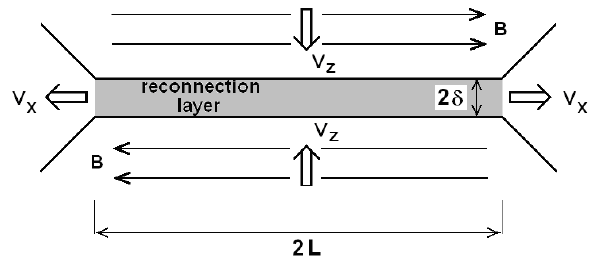
Fig. 1. The Sweet–Parker model. The magnetic fields, B , have op- posite directions above and below a thin reconnection layer. Plasma is frozen into the magnetic fields and enters the reconnection layer at the velocity V z and moves out of it at the velocity V x